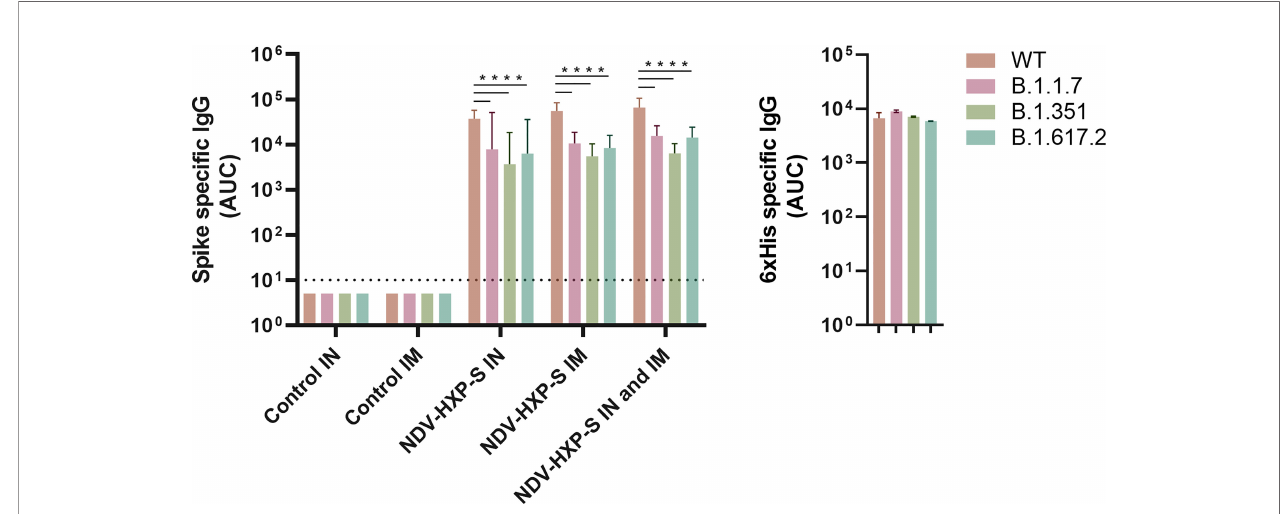
FIGURE 5 | Reactivity of sera from vaccinated rats against the spike of variants of concern (VOCs). Antibody levels against the spike protein from B.1.1.7, B.1.351, and B.1.617.2 variants of concern (VOCs) and wild type (WT) spike were measured by ELISA in sera from vaccinated rats 30 days after the fi rst vaccine dose administration (left panel). Antibody levels are expressed as area under the curve (AUC). As a control for antigen coating among the different spike proteins used, the reactivity towards the histidine tag present in all the recombinant proteins used is shown (right panel). Geometric mean with geometric standard deviation (SD) for the IN control, IM control, IN vaccinated, IM vaccinated, and IN-IM vaccinated groups is shown. Statistically signi fi cant differences between the reactivity against the spike of variants of concern (VOCs) and wild type spike are shown. Statistical signi fi cance is indicated as follows: ****P <